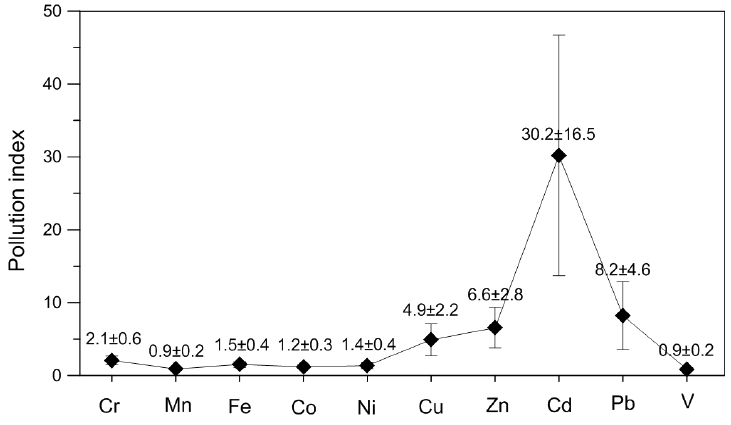
Figure 4. Pollution indexes (PIs) of heavy metals in the 43 settled dust samples from the Shijiazhuang urban area relative to the local natural soil.